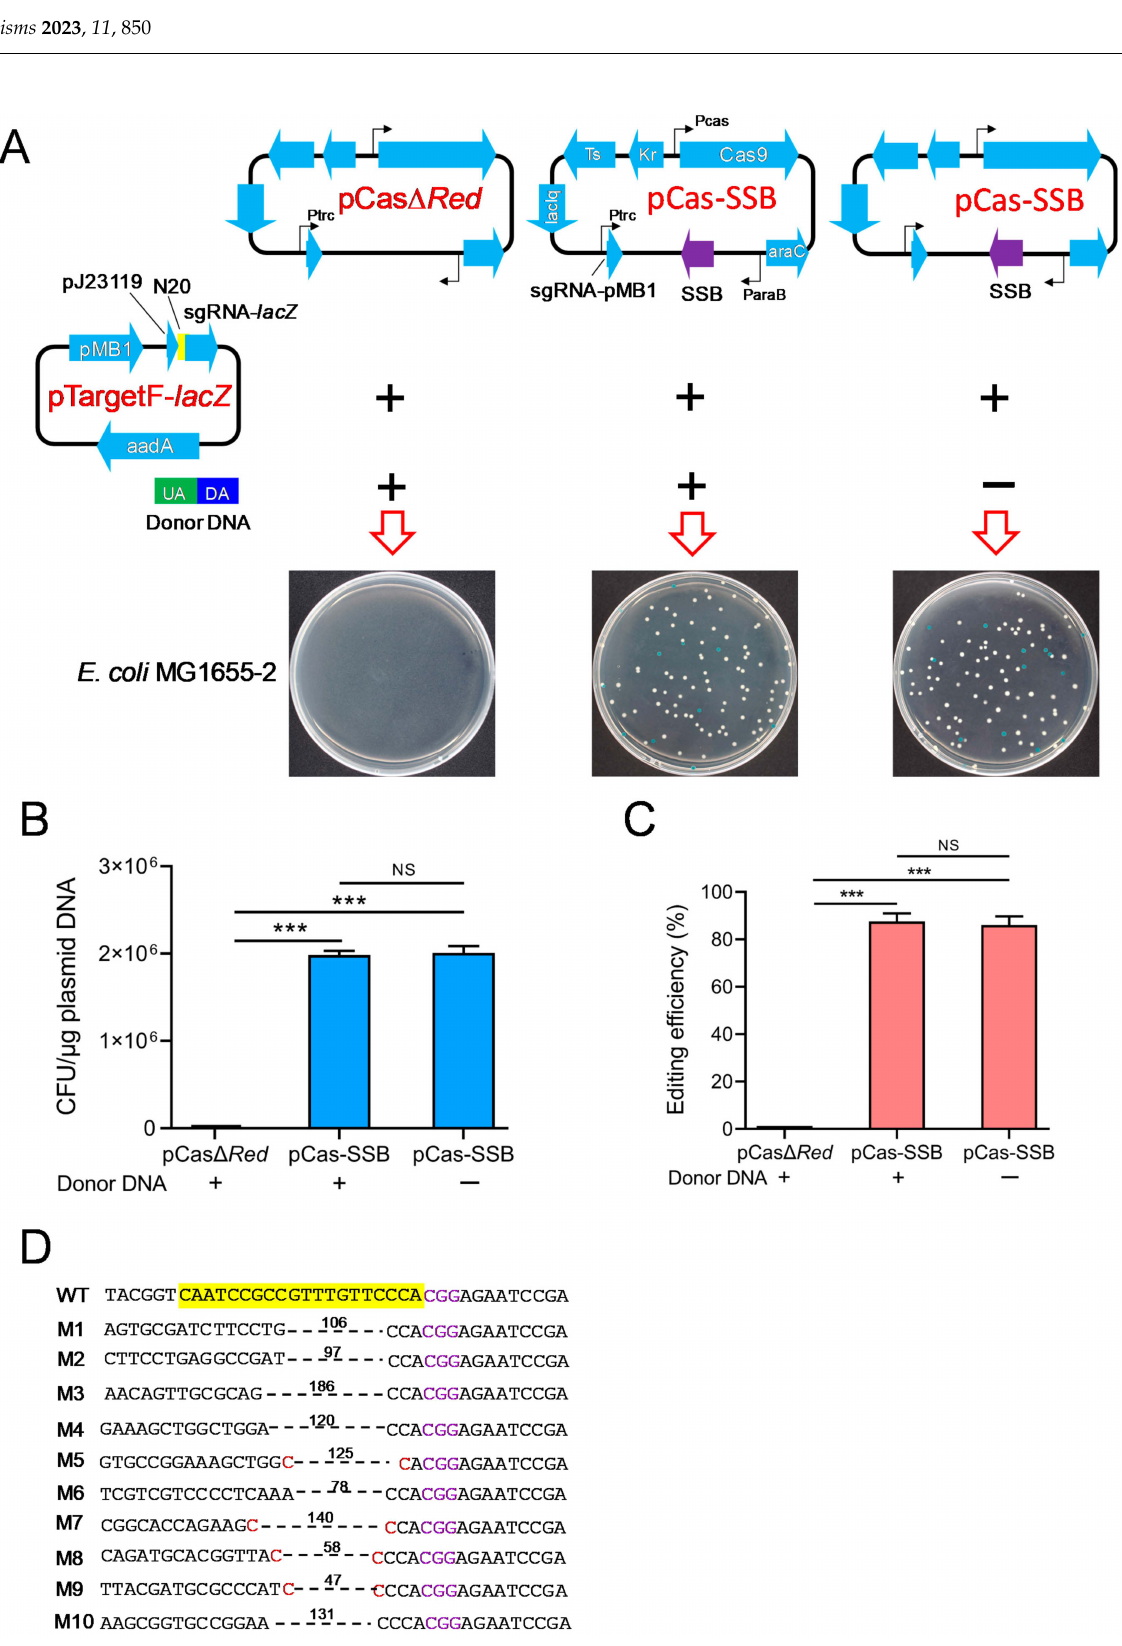
Figure 3. SSB repaired the DSBs and improved gene editing induced by CRISPR-Cas9 independent of RecA and RecBCD. ( A ) Schematic of the CRISPR-Cas9 two-plasmid system transformation into E. coli MG1655-2 ( ∆ recA , ∆ recBCD , ∆ SSB ) to delete the lacZ gene with or without donor DNA. ( B ) The transformation rate of the CRISPR-Cas9 plasmids into E. coli MG1665-2 with or without donor DNA. ( C ) The editing efficiency of CRISPR-Cas9 to delete the lacZ gene in E. coli MG1655-2 with or